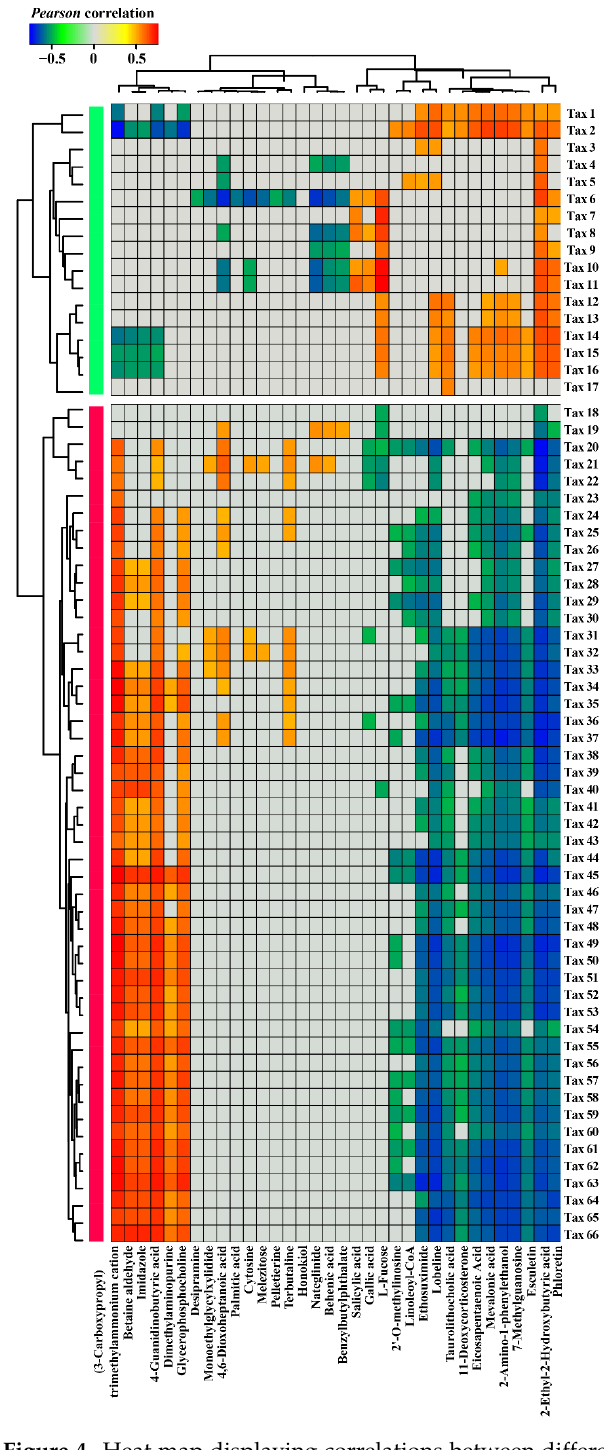
Figure 4. Heat map displaying correlations between differentially abundant bacterial taxa in the rhizosphere of WT and Nr tomato lines and root exudate metabolites. The plot displays the average Pearson correlations values between specific Nr -suppressed and Nr -enriched bacterial taxa (based on taxa relative abundances) and root exudate metabolites at the three distinct growth stages. Only Pearson correlation coefficients above 0.5 or below − 0.5 are shown. The light green and red columns represent the 17 Nr -suppressed and the 49 Nr -enriched bacterial taxa,